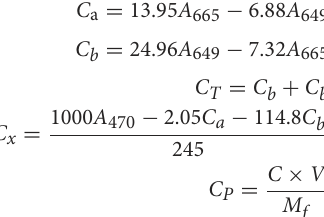
Measurement of photosynthetic pigment The photosynthetic pigment content of plant leaves was measured by 95% ethanol extraction. Grind, 0.2–0.5-g fresh leaves with 95% ethanol and filter the extract into a 25-ml brown volumetric flask to volume. Three repetitions of each treatment were measured. With 95% alcohol as the control group, the absorbance was measured by spectrophotometer at wavelengths of 665, 649, and 470 nm, respectively (Li M. et al., 2021). The formulas for calculating photosynthetic pigment content based on absorbance are as